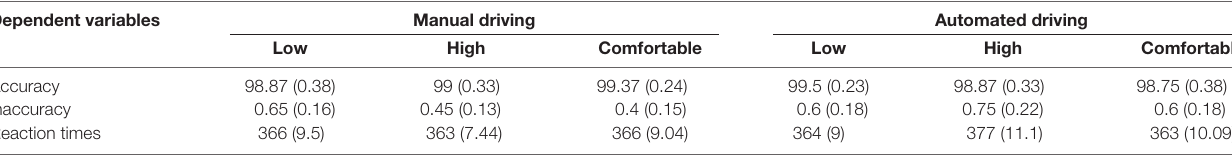
TABLE 1 | Scores in the oddball task in each condition.